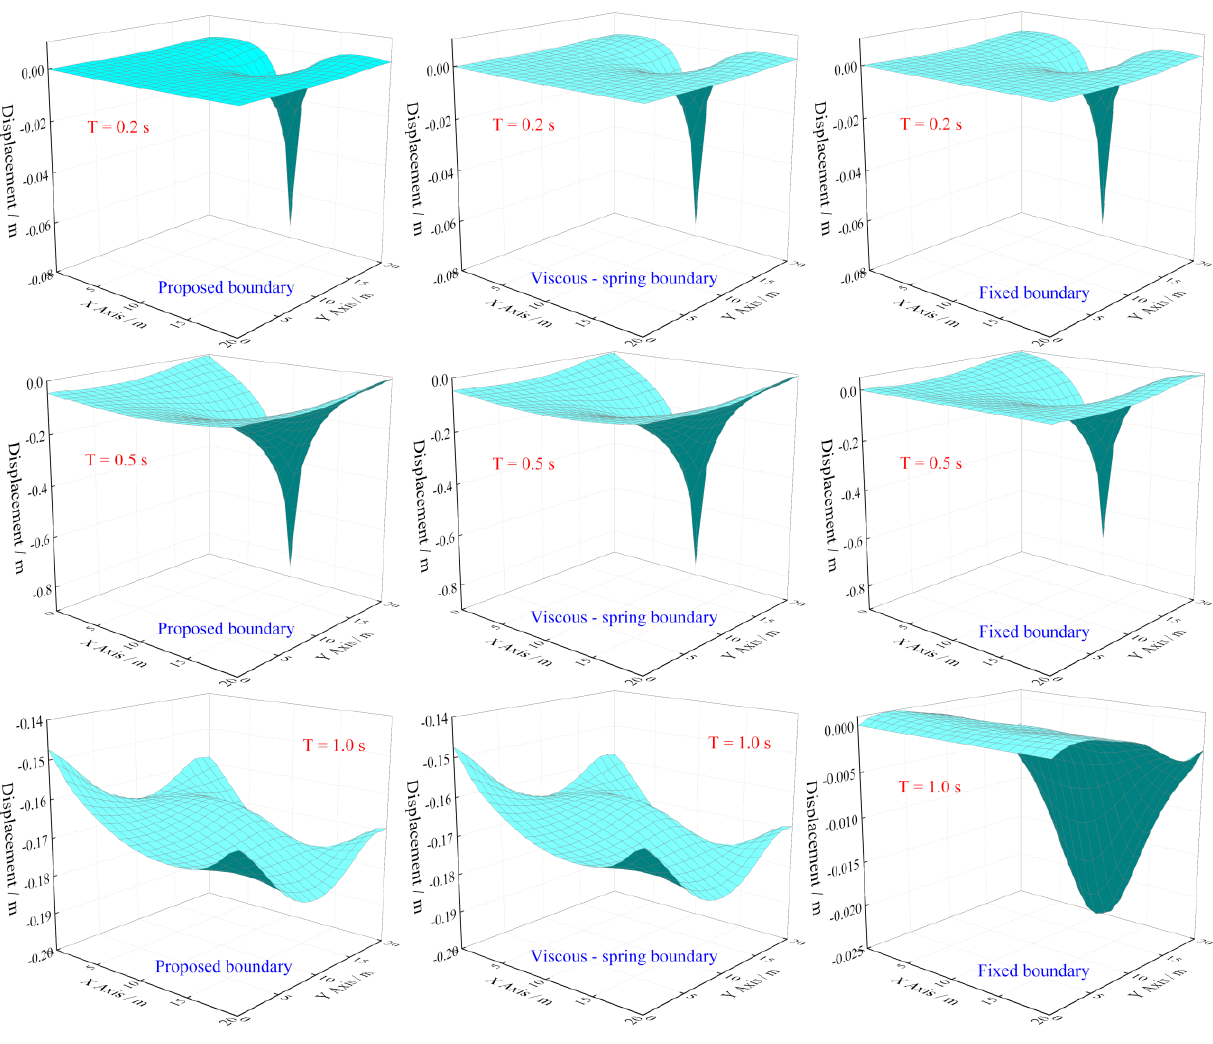
Figure 8. Comparison of displacement at different time.